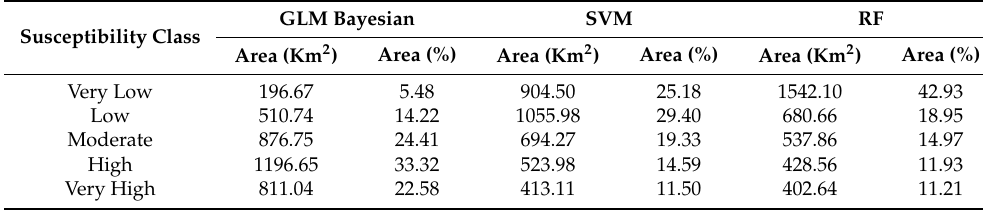
Figure 5. Piping susceptibility map using the three models: Bayesian GLM, RF, SVM. Table 3. Piping erosion susceptibility classes’ area.